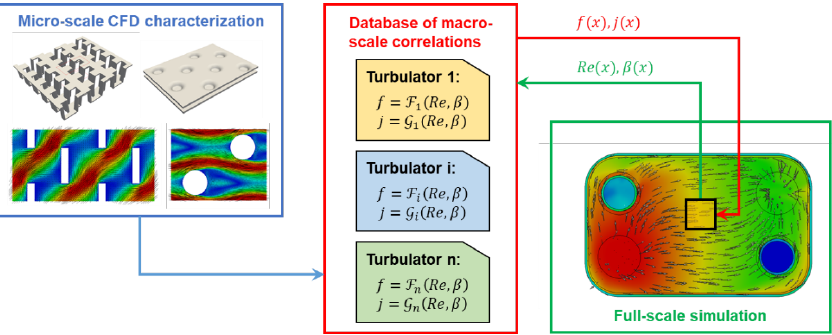
Figure 5. Integration between the simulations performed at the di ff erent